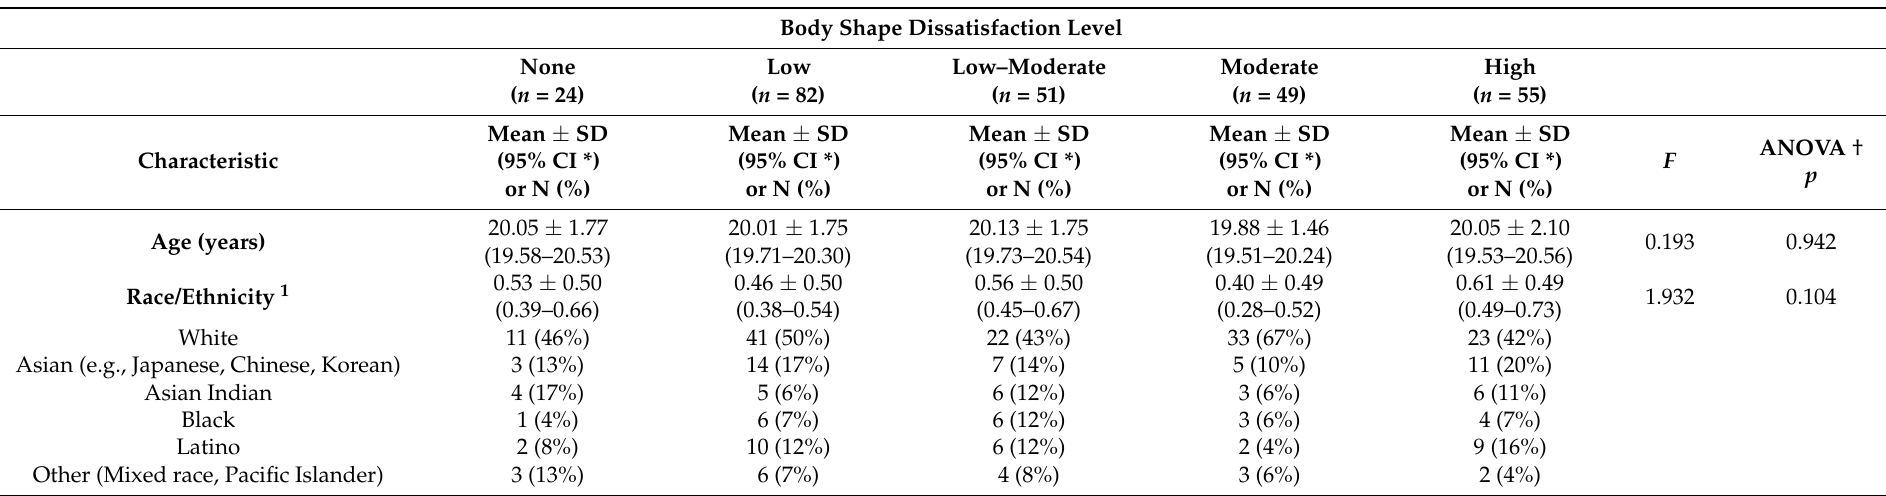
Table 1. Associations of Demographic Characteristics by Body Shape Dissatisfaction Level Among Young Adult Women College Students (N = 261).